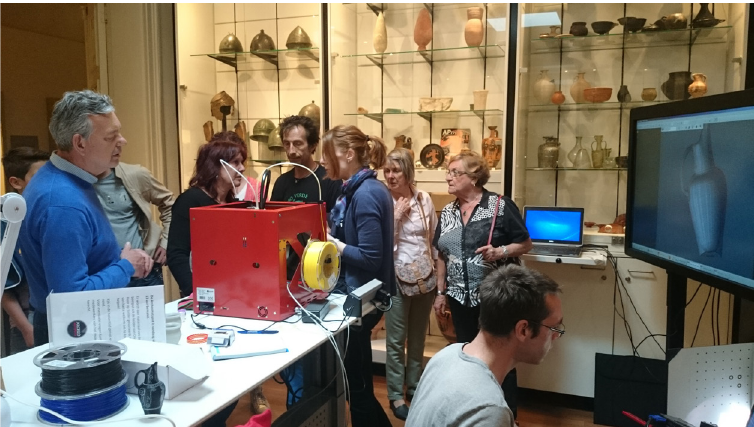
Figure 6. The PGP team performing research at the ArcheoHotspot . To the left the red 3D printer, on the right the touchscreen and just at the forefront a glimpse of the DAVID SLS-1 3D scanner. Photo by L.